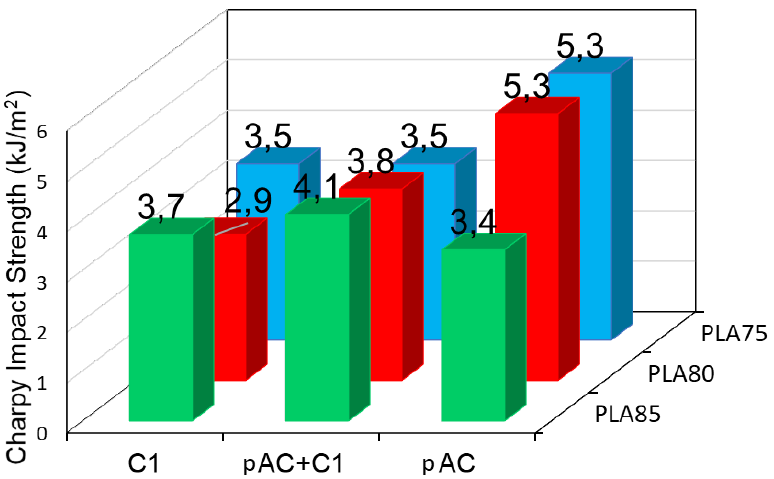
Figure 11. Charpy impact strength of the blends with 75, 80 and 85% of PLA and pure pAC, pAC/C1 in 4/1 ratio or pure C1.